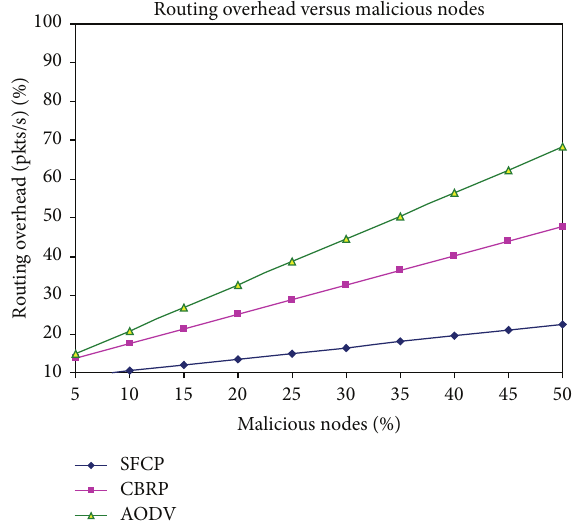
Figure 3: Routing overhead versus malicious